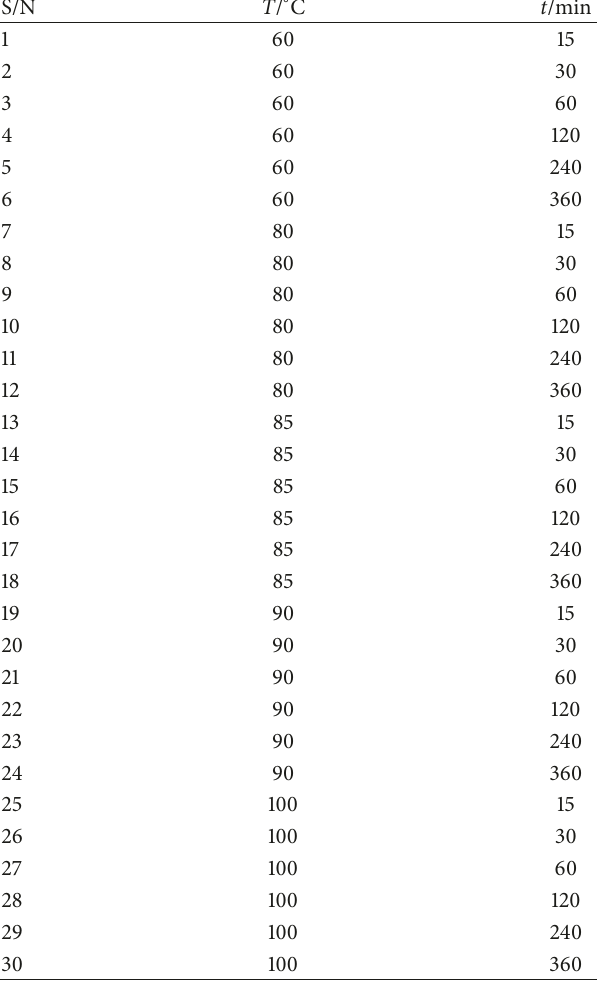
Table 1: Factors and levels table for experimental design.